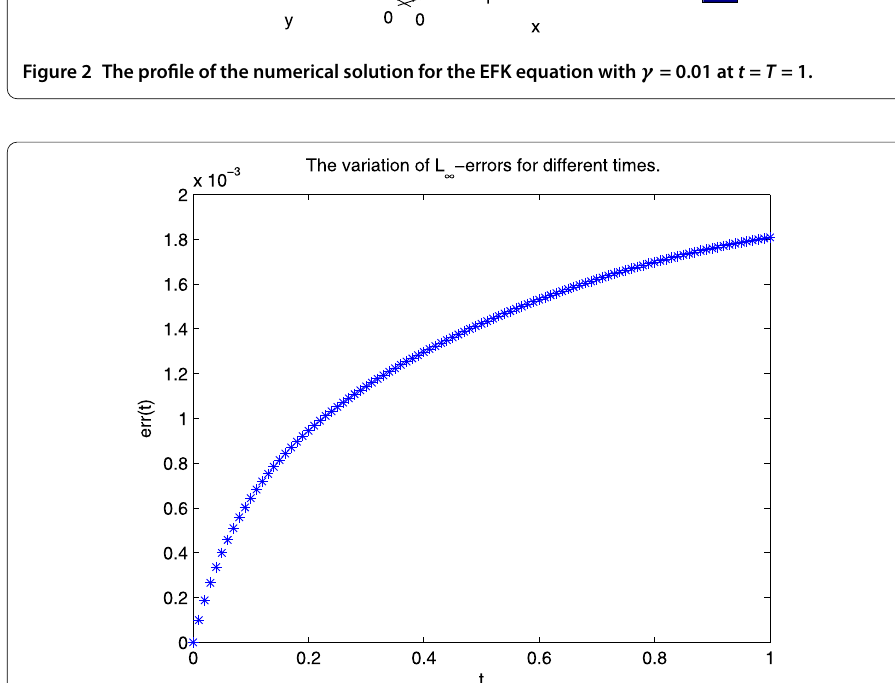
Figure 3 The profile of the variation of L ∞ -errors for different times with γ = 0.01 at t = T = 1.